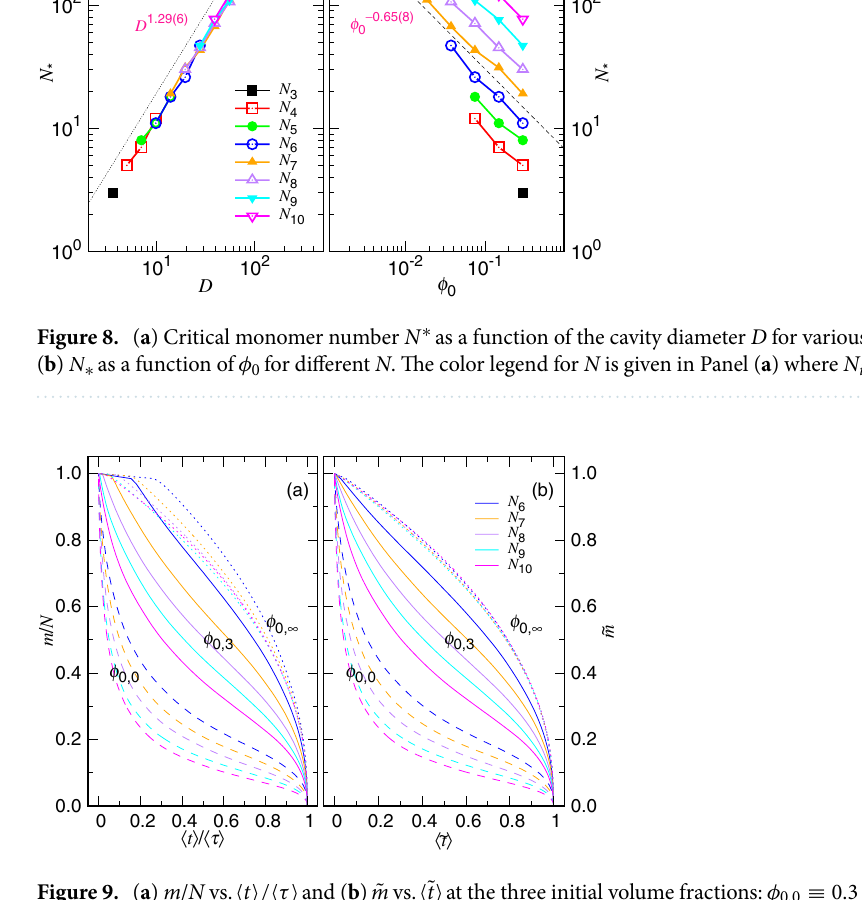
0.3 (in dashed line), ≡